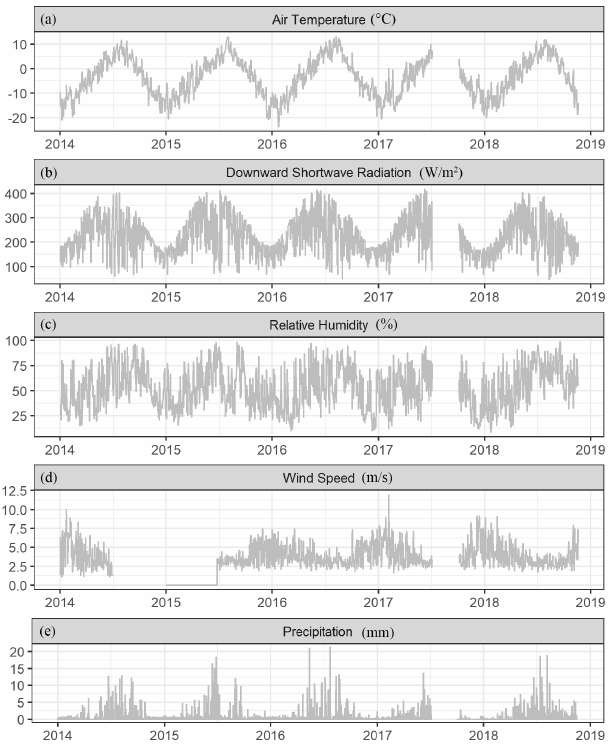
Figure 2. Time series (daily mean values) of the Xidatan field sta- tion from 2014 to 2018: (a–e) meteorological observation data.